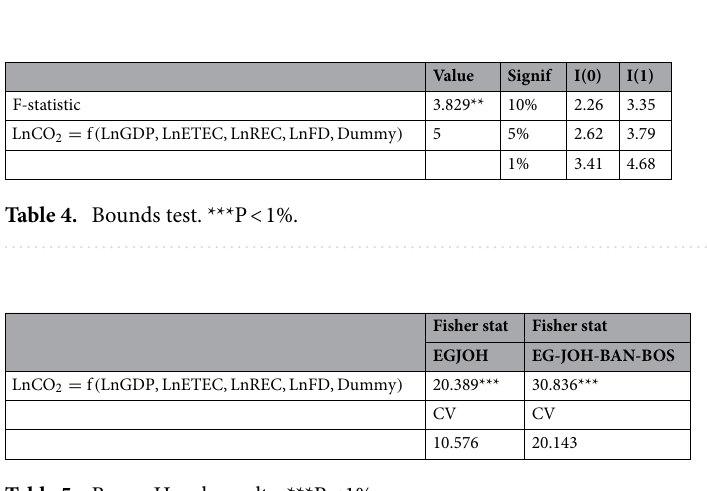
Table 5. Bayer–Hanck results. ***P <